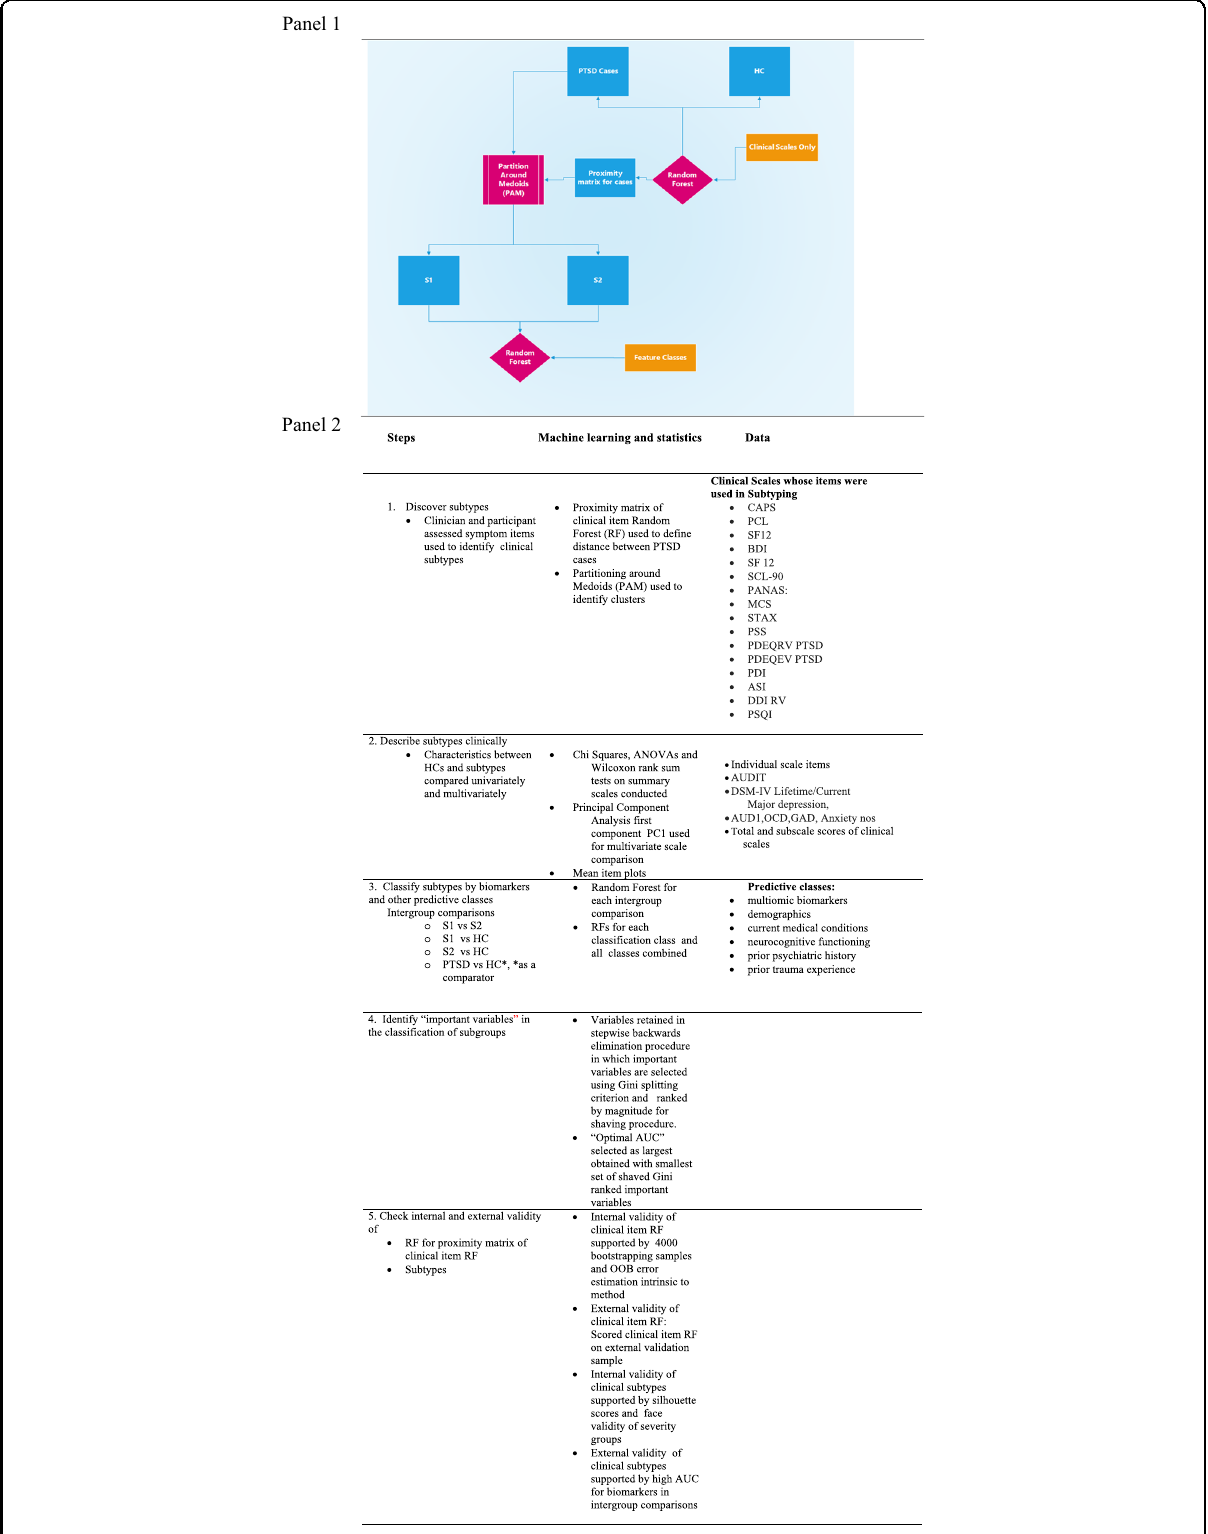
Fig. 1 Flow chart of analytic steps and speci fi c procedures. Panel 1: Flow chart of analytic steps. Panel 2: Speci fi c